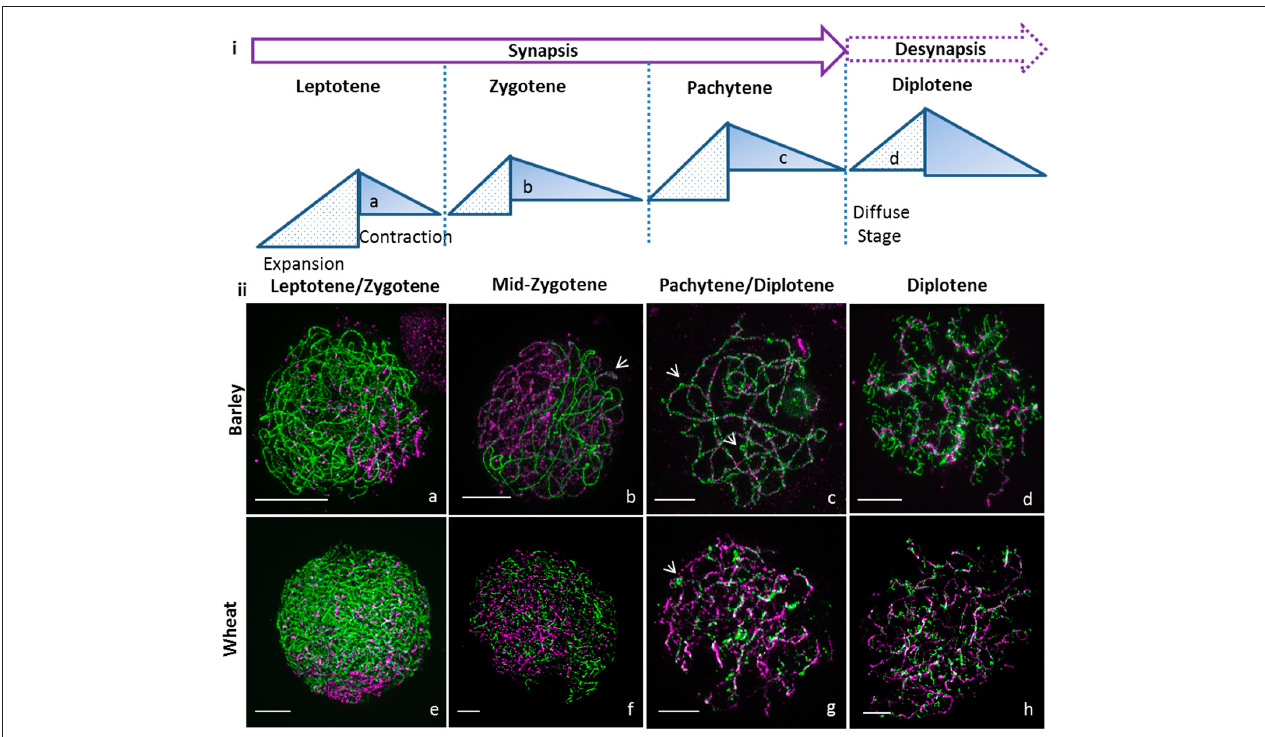
FIGURE 1 | Super resolution microscopy of synapsis in large genome cereals. (i) Cartoon of cycle of chromatin expansion and contraction as described in Kleckner et al. (2004) with indication of the diffuse stage. (ii) Synapsis was monitored using ASY1 (green) and ZYP1 (magenta) by 3D-SIM for barley Bowman (a–d) and wheat Chinese Spring (e–h) . Synapsis starts in leptotene at one end of the nucleus (a,e) and ZYP1 polymerizes to bring the chromosomes together during zygotene (b,f) though the tripartite structure of the synaptonemal complex is only visible in barley wt ( b , arrow). At pachytene, synapsis is complete in barley (c) and wheat (g) with ectopic ASY1 signals ( c , g , arrows). During diplotene, ASY1 remodels in both species (d,h) to form tinsel structures. Scale bar 5 µ